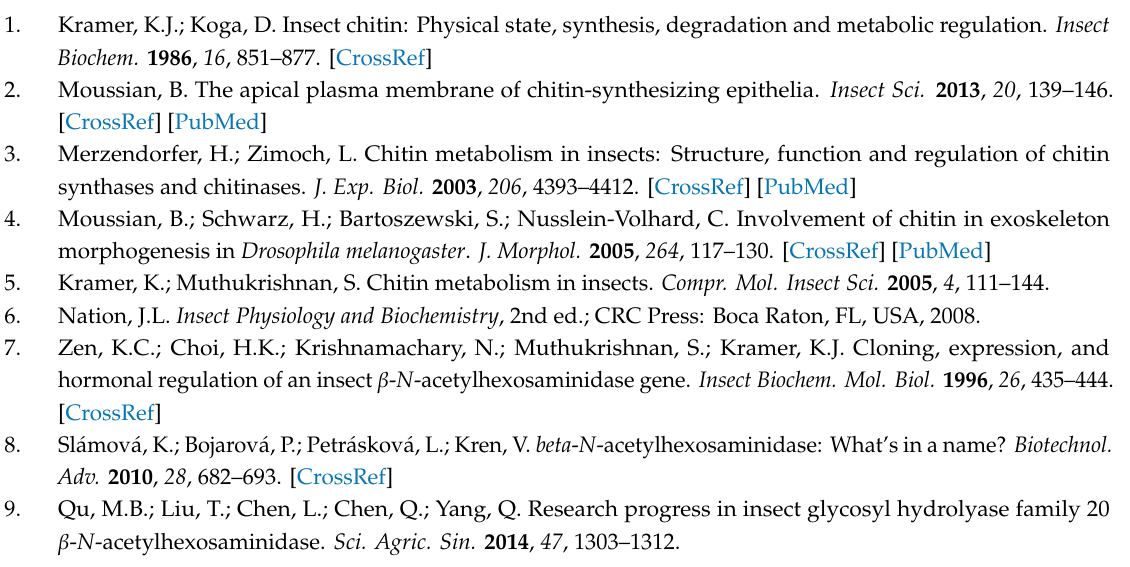
Table S1: Primers used in this study. Table S2: Details of β - N -acetylglucosaminidase protein sequences used for phylogenetic